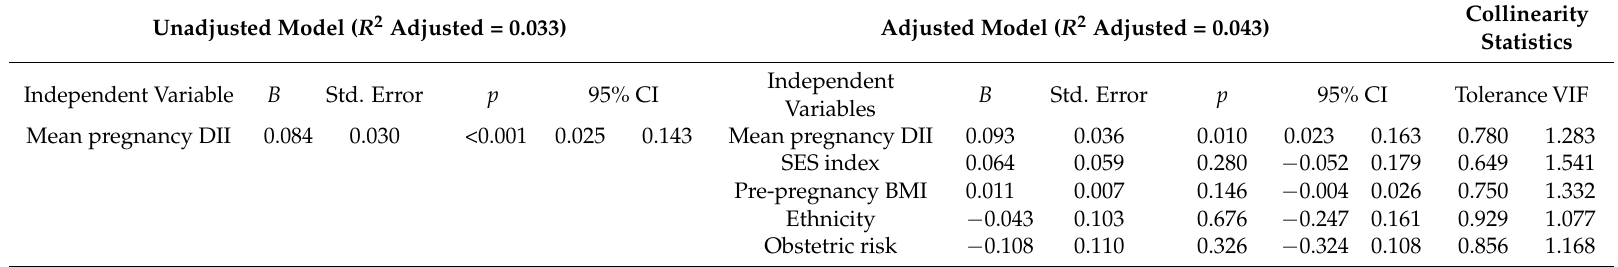
Table 3. Main effect of DII on TNF- α across pregnancy, unadjusted and adjusted for maternal covariates